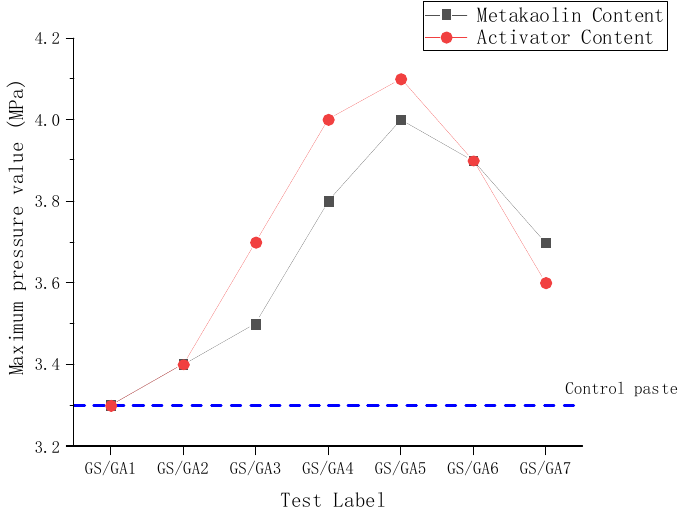
Figure 3. Maximum pressure values for GS/GA and cement control slurries.